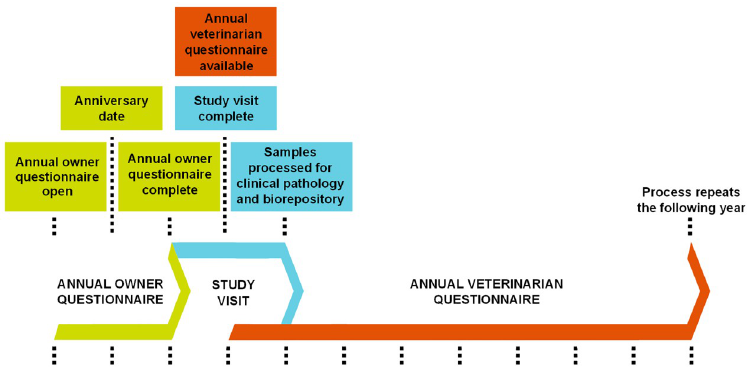
Fig 1. Study timeline and components. Three study components are conducted annually around the time of the dog’s anniversary date: 1) Annual Owner Questionnaire, 2) annual veterinary visit (‘‘Study Visit”), and 3) Annual Veterinarian Questionnaire. The Annual Owner Questionnaire is available from one month prior to the anniversary date until 10 months after the anniversary date, but most owners complete it within one month of the anniversary date. Once the owner completes the questionnaire, they are sent a sample collection kit and asked to schedule their Study Visit. At the Study Visit, a full physical examination is performed and core samples are collected for clinical pathologic processing and biorepository storage. The typical time between Annual Owner Questionnaire completion and Study Visit is one month. The veterinarian can complete the Annual Veterinarian Questionnaire any time after the Study Visit is completed. There is no requirement surrounding this time frame, but veterinarians are encouraged to fill it out as soon as they are able, ideally prior to the next Study Visit.